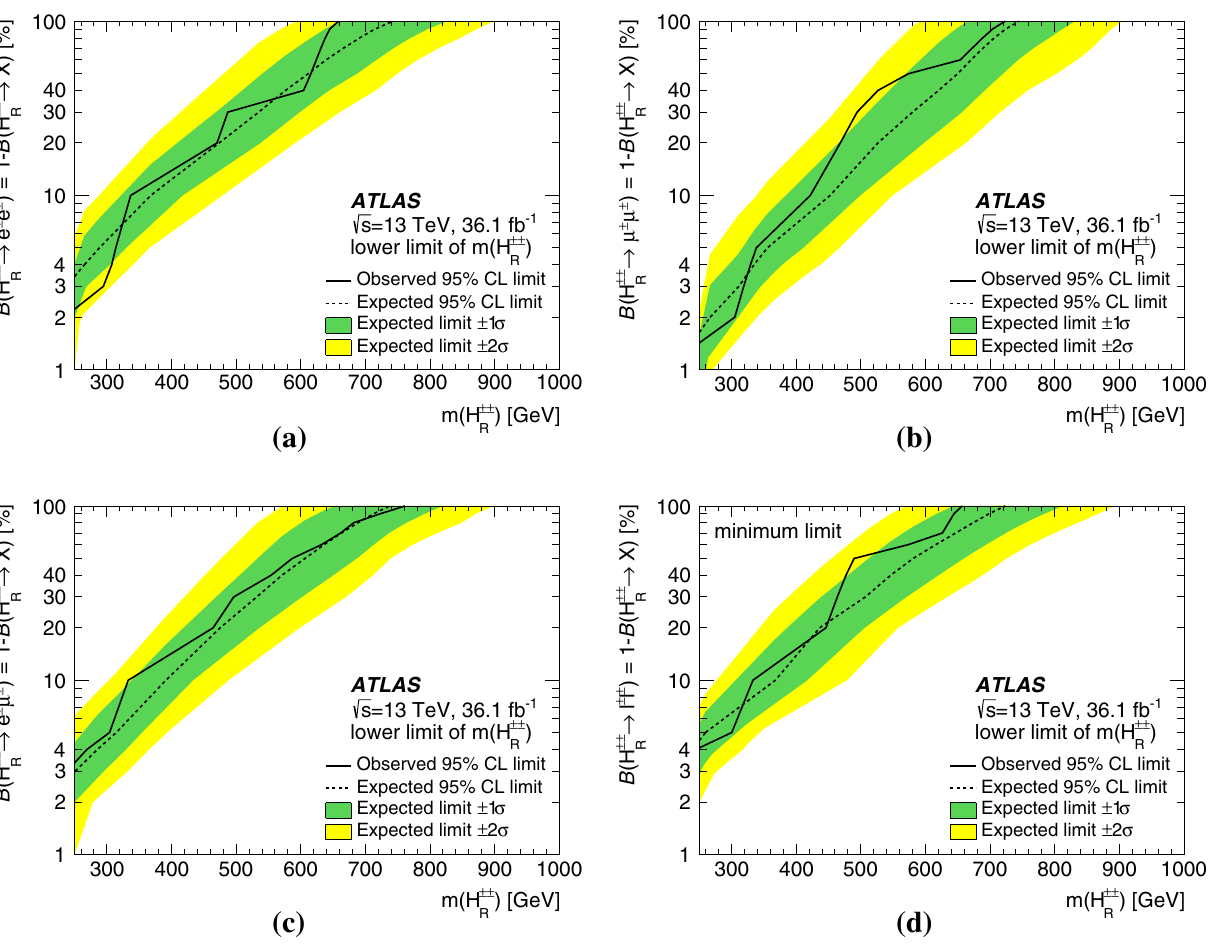
Fig. 14 Lower limit on the H ±± boson mass as a function of the decays only into electron–muon pairs and “ X ”, with “ X ”, and c H ±± R R → (cid:3) ± (cid:3) ± ) . Several cases are presented: a H ±± “ X ” not entering any of the signal regions. Plot d shows the minimum branching ratio B ( H ±± R R observed and expected limit as a function of B ( H ±± decays only into electrons and “ X ”, b H ±± decays only into muons and R